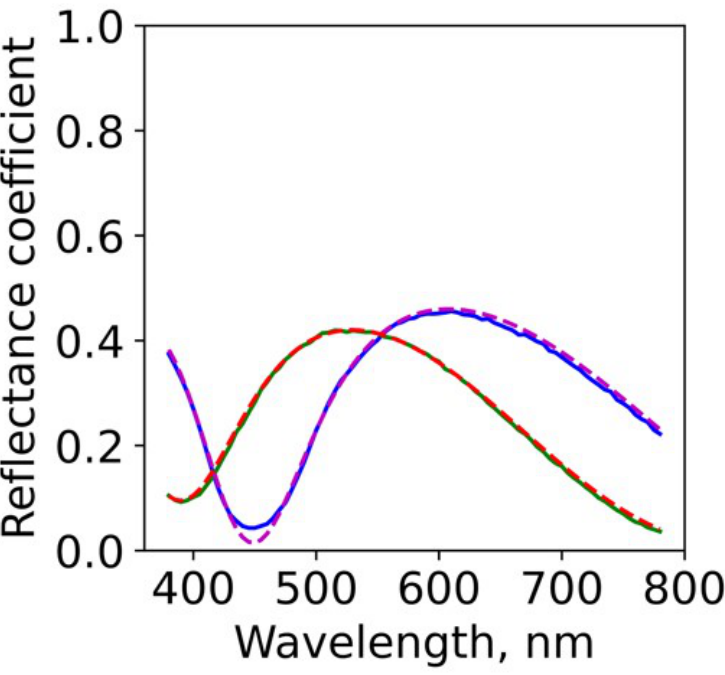
Figure 6. Model output (solid lines) compared with TMM calculations using the model predic- tions (dashed lines) for two sample structures with material depths [35.6 52.7 36.9 22.1 46.1 72.0] and [47.1 25.3 23.8 22.6 51.8 68.4] nm, respectively. The strong similarities indicate good agreement between the analytical and numerical